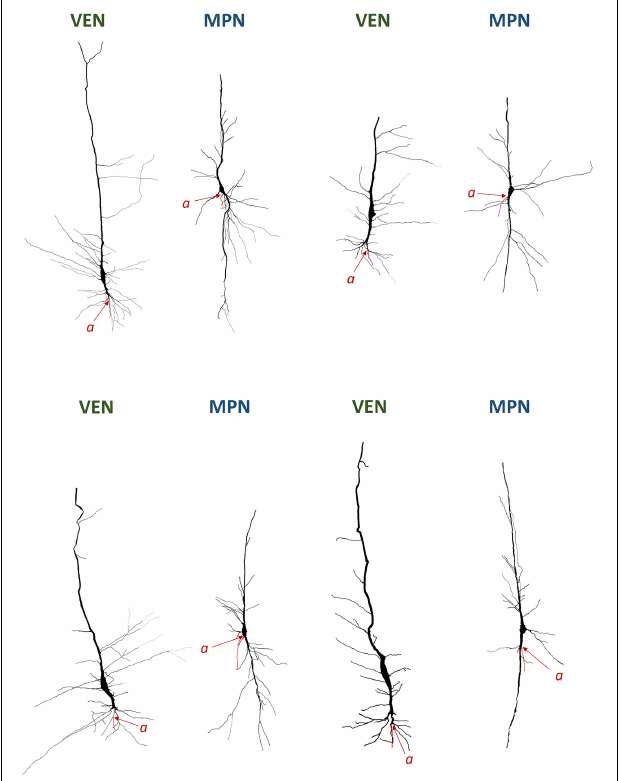
FIGURE 7 | Neurolucida 3D reconstructions of VENs and common modified pyramidal neurons (MPN) found in the human cerebral cortex. The axon origin is marked by “ a ” and the axon is traced in red. Note the differences in axon origin between VENs and common MPNs as well as the brush-like terminal branching of the basal dendrite in VENs that is not present in common MPNs. Image modified from Banovac et al. (2019).